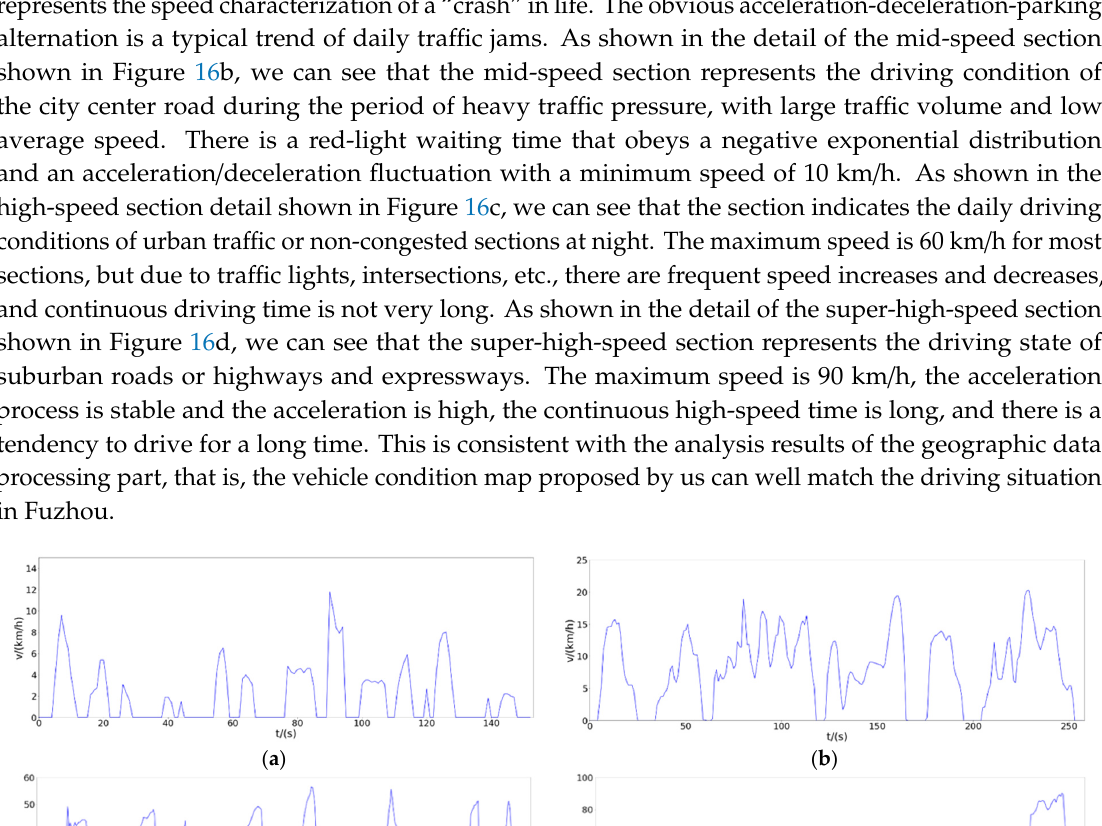
Table 5. Comparison of the driving cycle map and the actual data set parameters. Actual Data Set